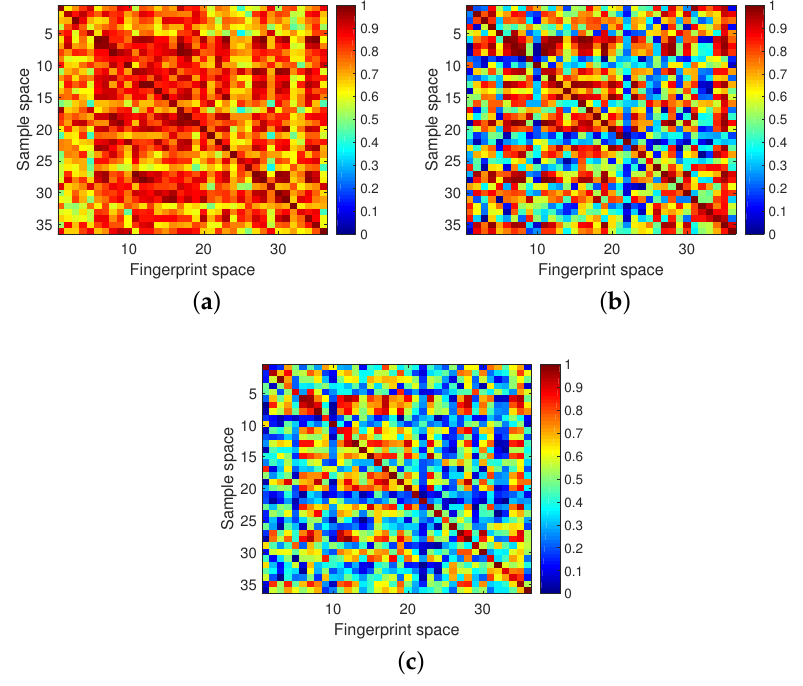
Figure 12. The localization results by using three different parameters. ( a ) η F